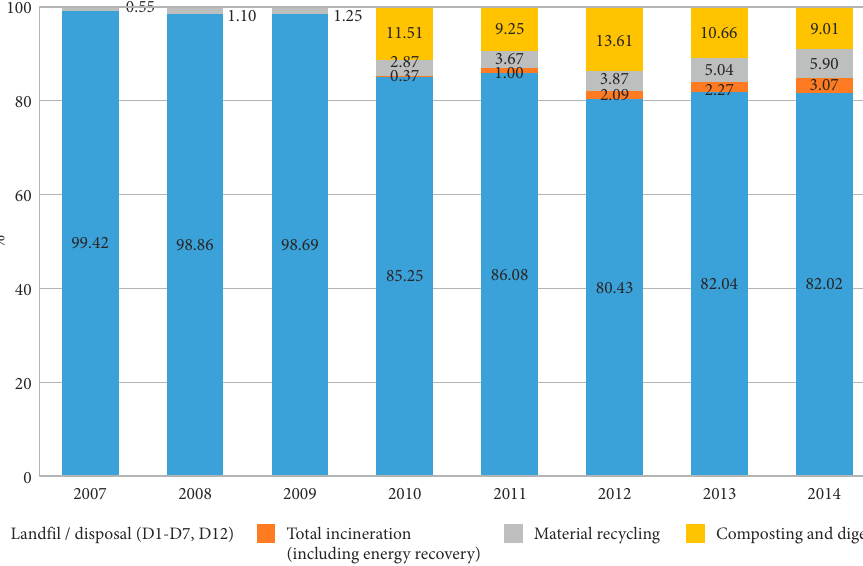
Figure 5. Structure of municipal waste by type of treatment, in Romania, during 2007–2014 (source: Own elaboration based on Eurostat data,